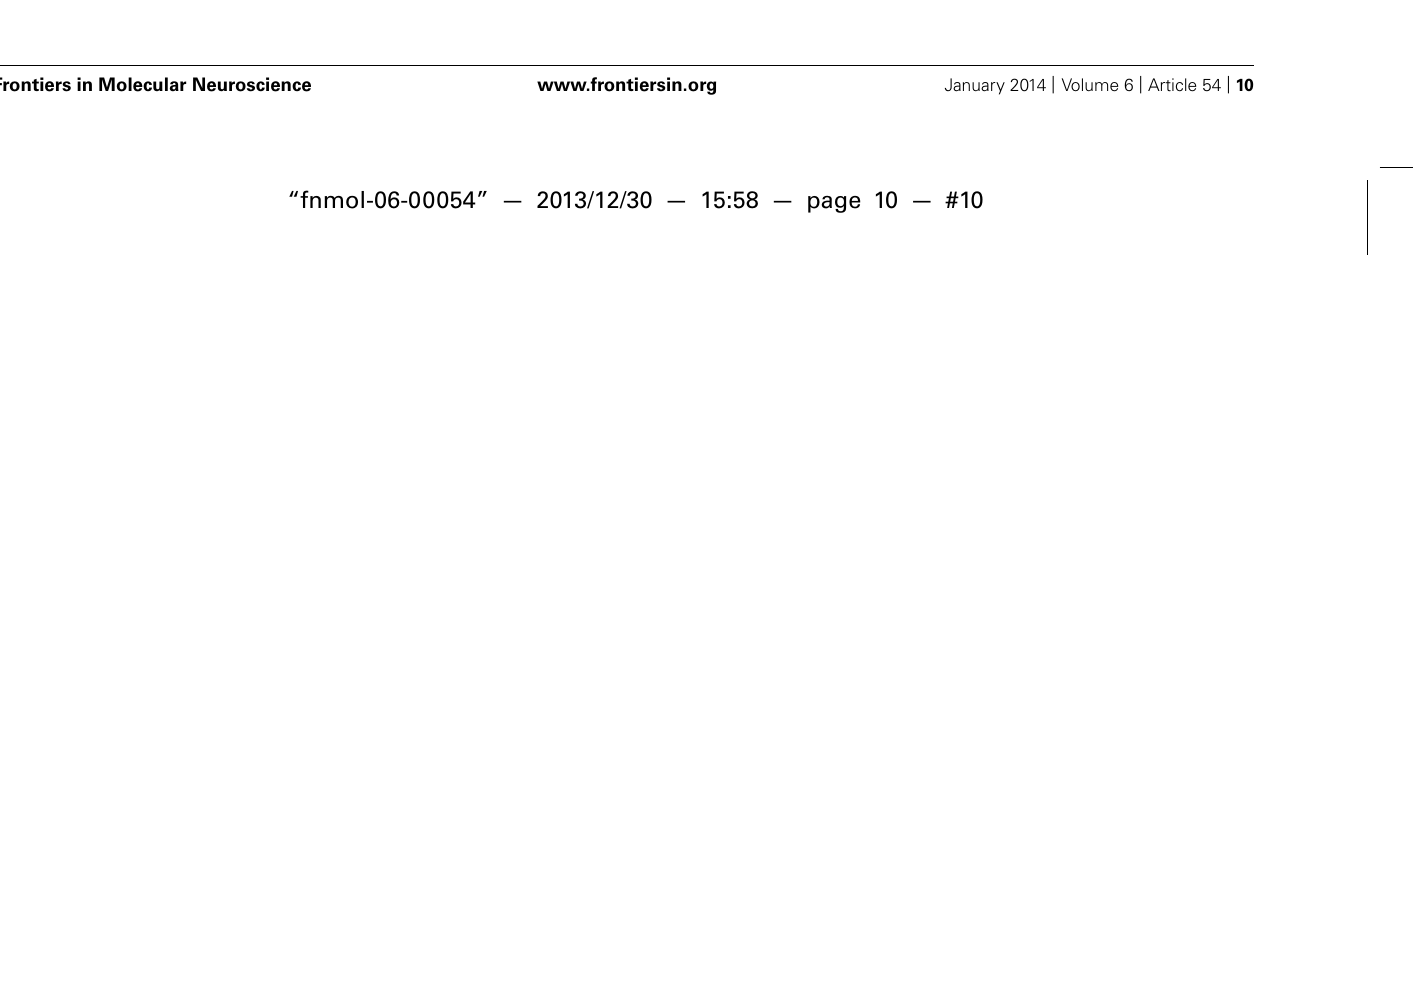
analyzed in the different cultures was: 95 for Control, 91 for PI3K, 109 for control + TTX, 113 for PI3K + TTX and 137 for LY294002. (C) NMDAR receptor activation appears to be necessary for the formation of PI3K-induced spines. As before, spine density in response to PI3K activation was quantified in sister cultures under normal conditions (control versus PI3K) and in the presence of the NMDA receptor inhibitor d-APV (PI3K + APV). Spine density was significantly higher in PI3K as compared to the control culture (1.39 ± 0.04 versus 1.19 ± 0.03 spines/ μ m, respectively), whereas in the PI3K + APV culture, spine density was reduced back to control levels (1.16 ± 0.03 spines/ μ m) (Student’s t -test). (D) Representative dendritic segments from control (a), PI3K (b) and PI3K + APV (c) cultures. Scale bar = 2.5 μ m. A total of 79 control; 73 PTD4-PI3KAc and 73 PTD4-PI3Kac + d-APV dendrites from four different cultures were